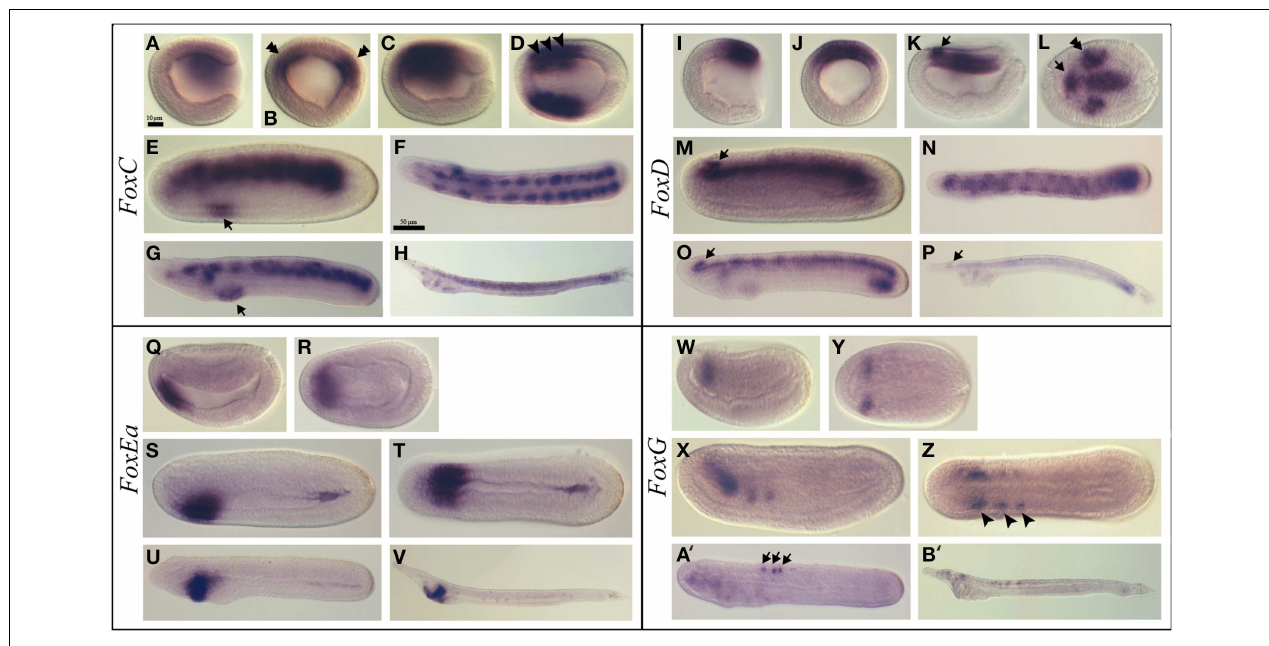
FIGURE 3 | Expression of B. lanceolatum FoxC , FoxD, FoxEa, and FoxG . In all the panels except (B,J) , anterior is to the left. In lateral and blastoporal views dorsal is to the top. FoxC expression pattern (A–H) . Gastrula lateral (A) and blastoporal (B) views. The double arrowhead indicates the expression in the paraxial mesoderm. Late gastrula lateral (C) and dorsal (D) views. The arrowheads marks the region that will give rise to the three most anterior somites. In mid-late neurula lateral view (E) the arrow indicates a new expression domain in the anterior endoderm. Late neurula dorsal (F) and lateral (G) views. The arrow marks the expression domain in the pharynx. Larva lateral view (H) . FoxD expression pattern (I–P) . Gastrula lateral (I) and blasporal (J) views. Late gastrula lateral (K) and dorsal (L) views. The arrow indicates the expression in the anterior region of the neural